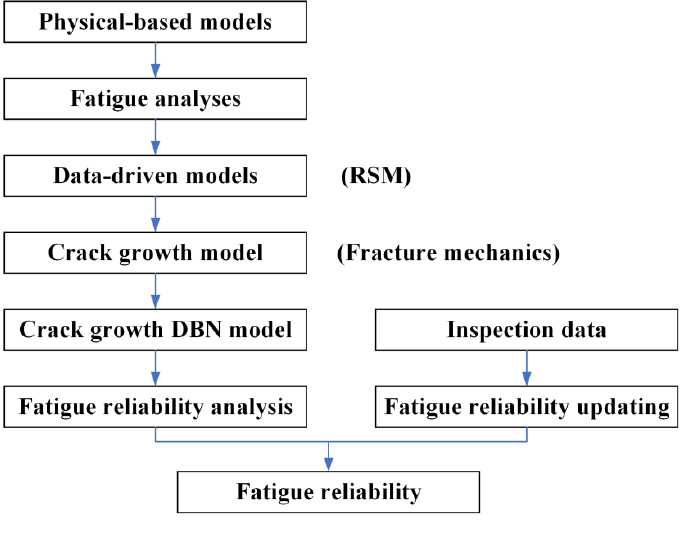
Figure 1. Analysis methodology.